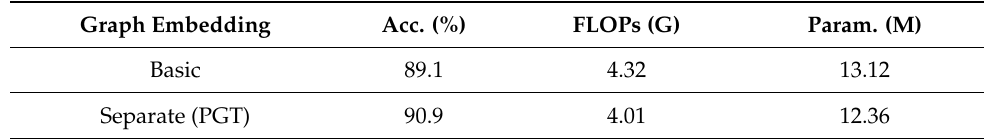
Table 4. The ablation study on the NTU-RGBD 60 CS benchmark, denoting the effect of separate convolution in graph